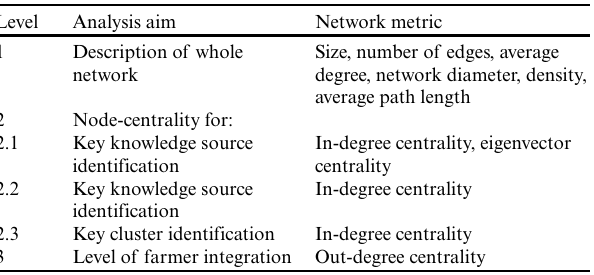
Table 2. Overview of the analysis levels and aims, and the corresponding network metrics